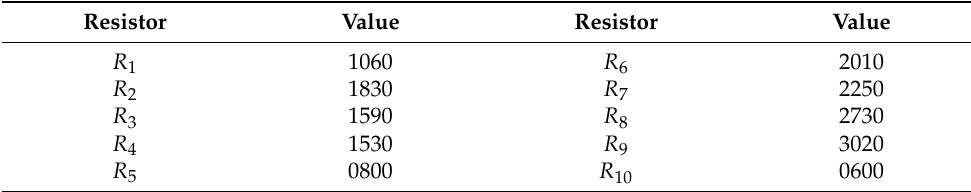
Table 8. Resistor values for the Veracruz-Boca del Rio map.